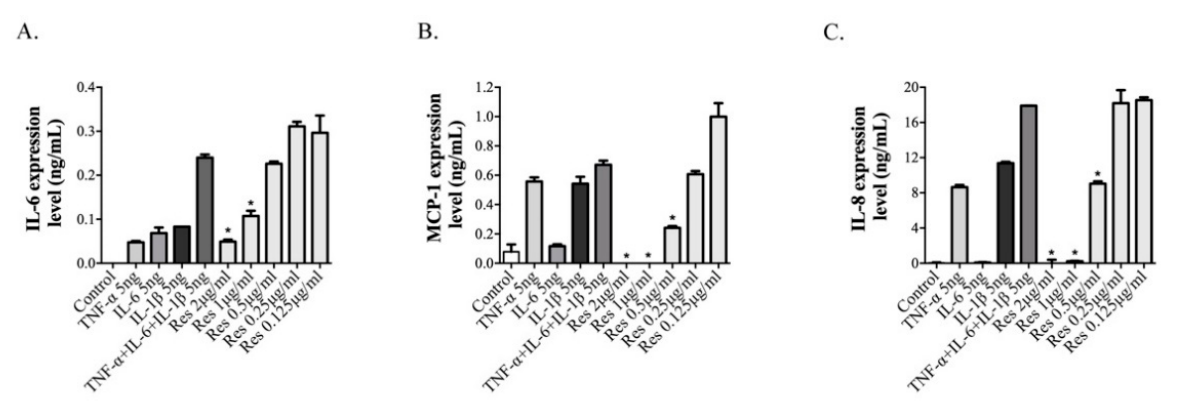
Figure 3. Effect of resveratrol on inflammatory cytokine expression in pro-inflammatory cytokine-stimulated ARPE-19 cells. Cells were pretreated with pro-inflammatory agents (TNF- α , IL-6, and IL-1 β alone and in combinations) for 10 min and subsequently treated with 0.125–2 µ g/mL of resveratrol for 2 h. ( A ) IL-6, ( B ) MCP-1, and ( C ) IL-8 levels were measured by ELISA. The values represent the mean ± SD of triplicate determinations from three independent experiments. * p < 0.05 indicates significant differences between combinations of pro-inflammatory agents and resveratrol.